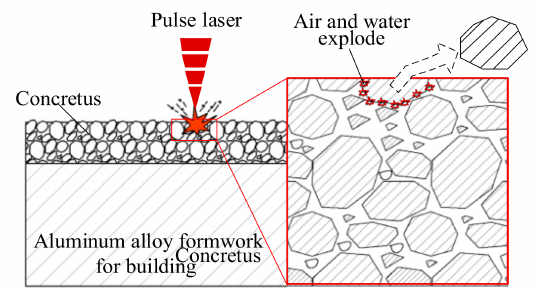
Figure 8. Laser cleaning mechanism of thick concrete slurry